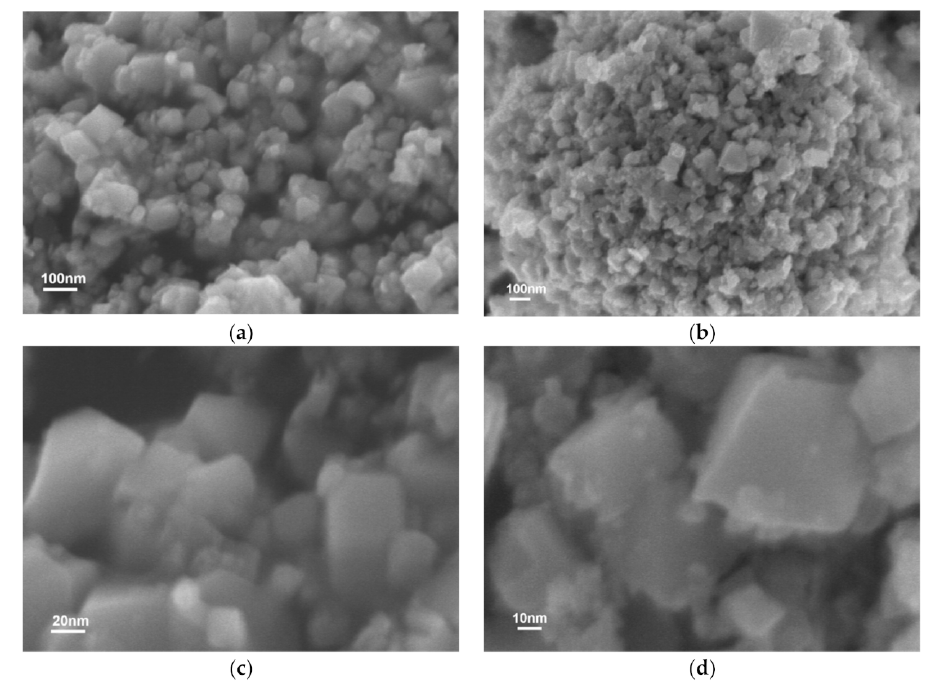
Figure 4. SEM image of CdIn 2 S 4 ( a , c ) and MoS x / CdIn 2 S 4 ( b , d